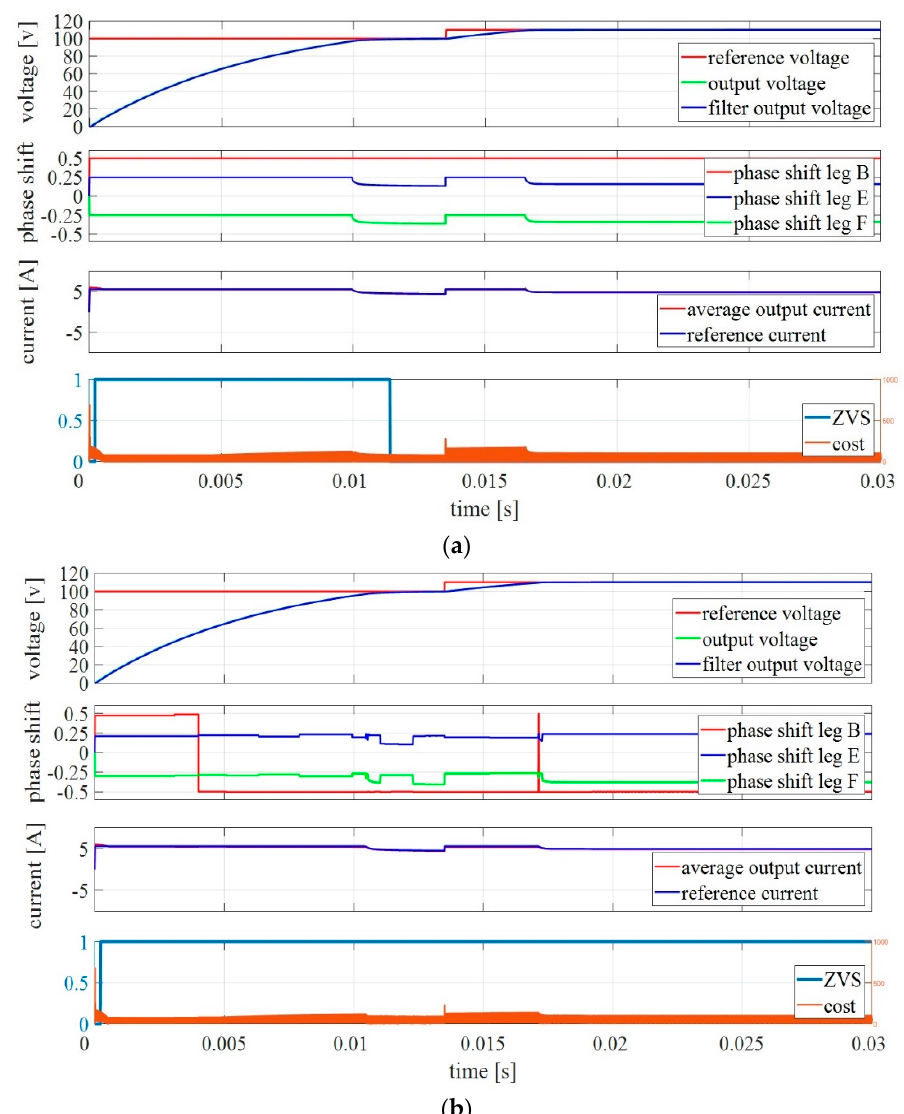
Figure 12. Output voltage control with startup from zero and step test (100 to 110 V): ( a ) SPS modulation; ( b ) Optimized modulation.